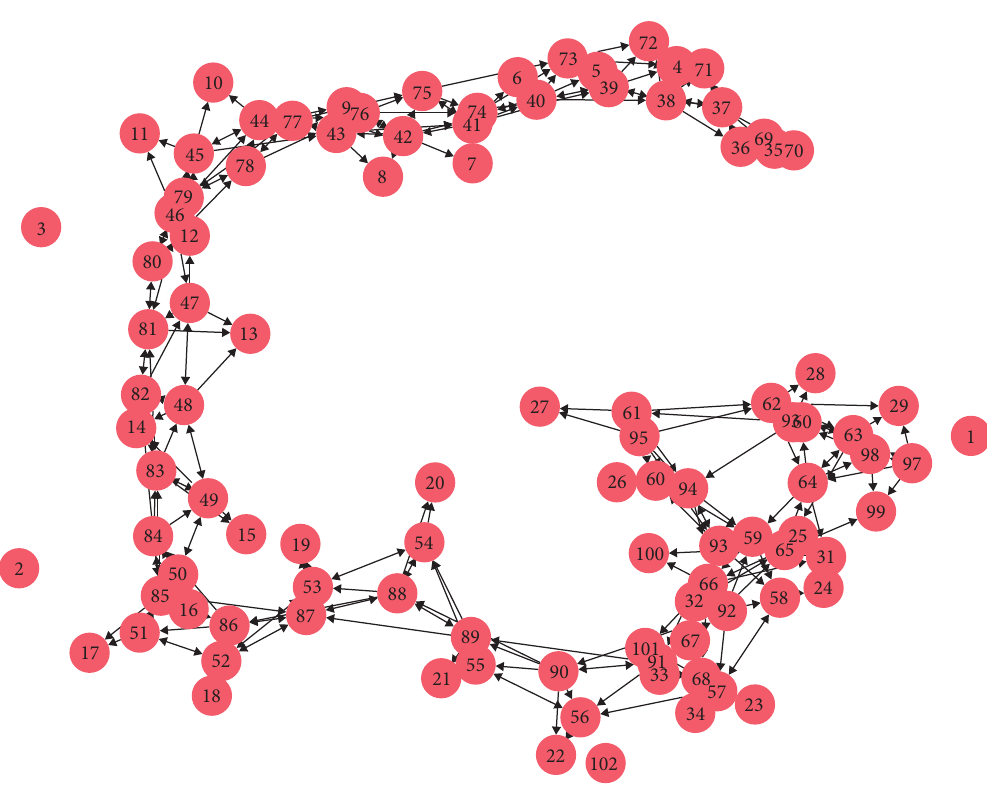
Figure 6: Directed weighted network of the entrance and exit.